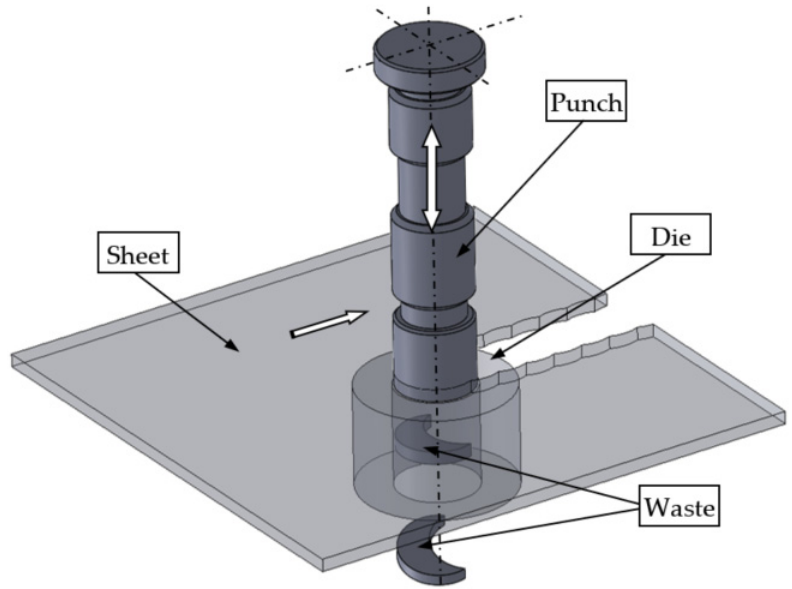
Figure 1. Illustration of the nibbling process.